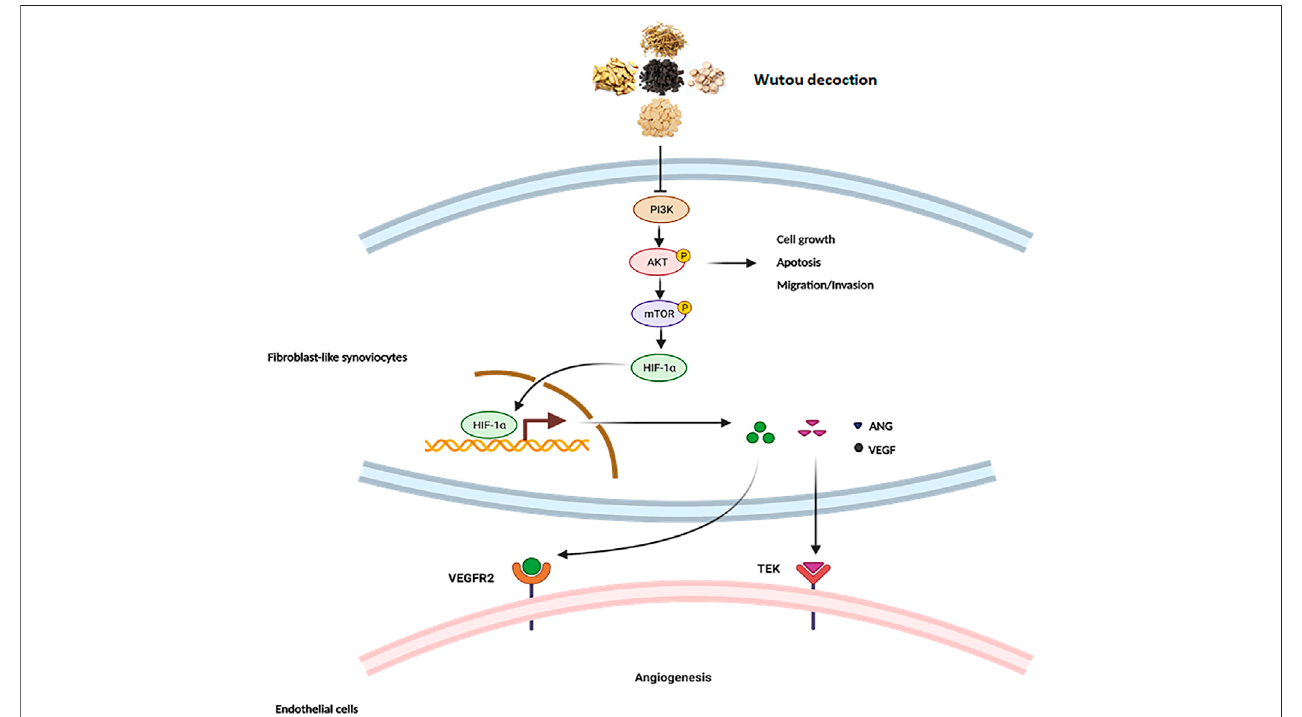
FIGURE 9 | The mechanism of WTD against angiogenesis in RA. Overview of the underlying mechanisms of WTD treatment by the PI3K/AKT/mTOR signaling pathway. Activation of PI3K by receptor tyrosine kinases promotes cell growth, proliferation, migration and invasion as well as angiogenesis. PI3K signaling can activate and phosphorylate AKT, andp-AKTcan inhibitthe expression ofapoptosis-related genestoallowthecells tosurvivewhile promotingtheexpression ofgenesrelated to cell proliferation, migration, and invasion. More importantly, p-AKT can activate mTOR to upregulate the expression of HIF1 α . HIF-1 α is stabilized under hypoxic conditions and quickly translocated to the nucleus, where it facilitates the expression of the associated genes VEGF and ANGI). However, VEGF and ANGI can bind corresponding homologous receptors coupled to endothelial cells to promote synovial angiogenesis. PI3K, Phosphatidylinositide 3-kinases; AKT, protein kinase B; mTOR, Mammalian target of rapamycin; HIF-1 α , Hypoxia-induced factor 1 α ; VEGF, Vascular endothelial growth factor; VEGFR2, Vascular endothelial growth factor receptor 2; ANG1, Angiopoietin 1; TEK, Angiopoietin-1 receptor.